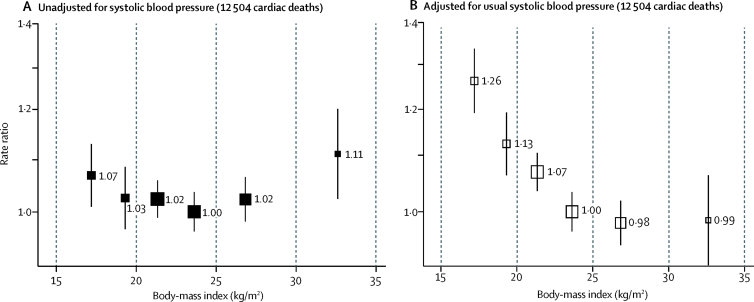
Body-mass index vs cardiac mortality at ages 35–69 years in Chennai, India, unadjusted for systolic blood pressure (A), and adjusted for systolic blood pressure (B)Rate ratios were adjusted for major confounders (age, sex, education, socioeconomic status, smoking, and alcohol), and omitted the first 2 years of follow-up. Exclusions are as per table 1. For each body-mass index category, the area of the square is inversely proportional to the variance of the category-specific log risk, which also determines the 95% CI (represented by error bars).